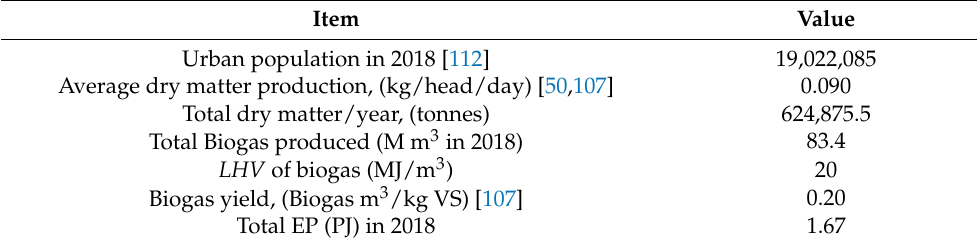
Table 11. The biogas potential and EP available from urban human waste in Tanzania.